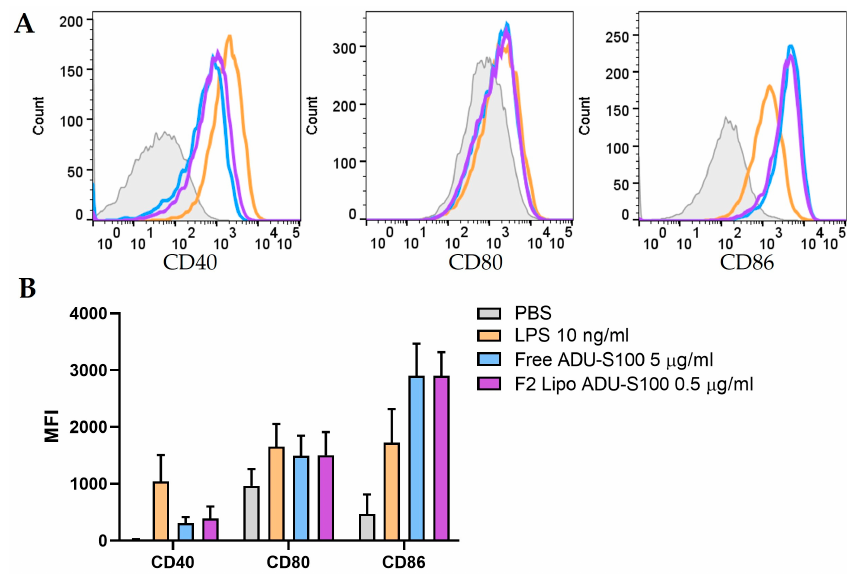
Figure 7. Liposomal ADU-S100 promotes the maturation of dendritic cells. ( A ) Representative flow cytometry histograms of CD40, CD80, and CD86 expression after the stimulation of BMDCs with free ADU-S100 (5 µg/mL) or liposomal ADU-S100 (0.5 µg/mL) for 6 h. LPS (10 ng/mL) was used as a positive control. ( B ) Mean fluorescence intensity (MFI) for CD40, CD80, and CD86 are summarized with bar graphs. Data are shown as the mean ± SD ( n ≥ 3) and are representative of three independent experiments.